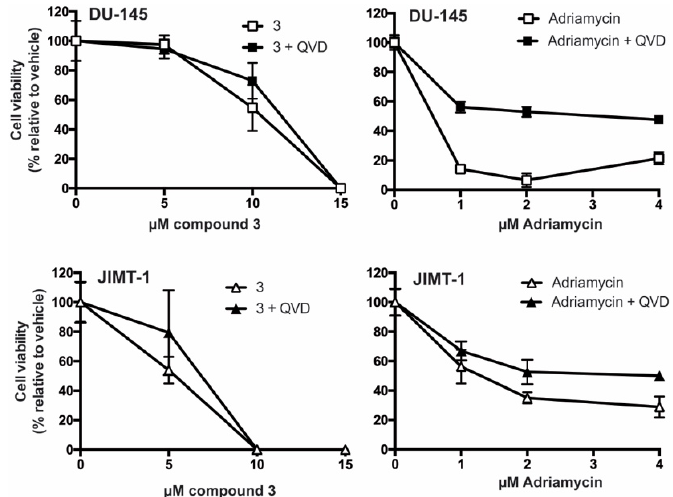
Figure 4. Demonstration of caspase/apoptosis independent cell death. DU ‐ 145 or JIMT ‐ 1 cell lines were treated with increasing concentrations of 3 or Adriamycin in the presence or absence of 40 μ M QVD. Four hours after plating, cells were treated with QVD. After 20 h, the cells were incubated with 0–15 μ M 3 or 0–4 μ M Adriamycin for 48 h. Cell viability relative to vehicle control was measured by MTS assay. The results represent the mean ± standard deviation of 6 independent determinations.